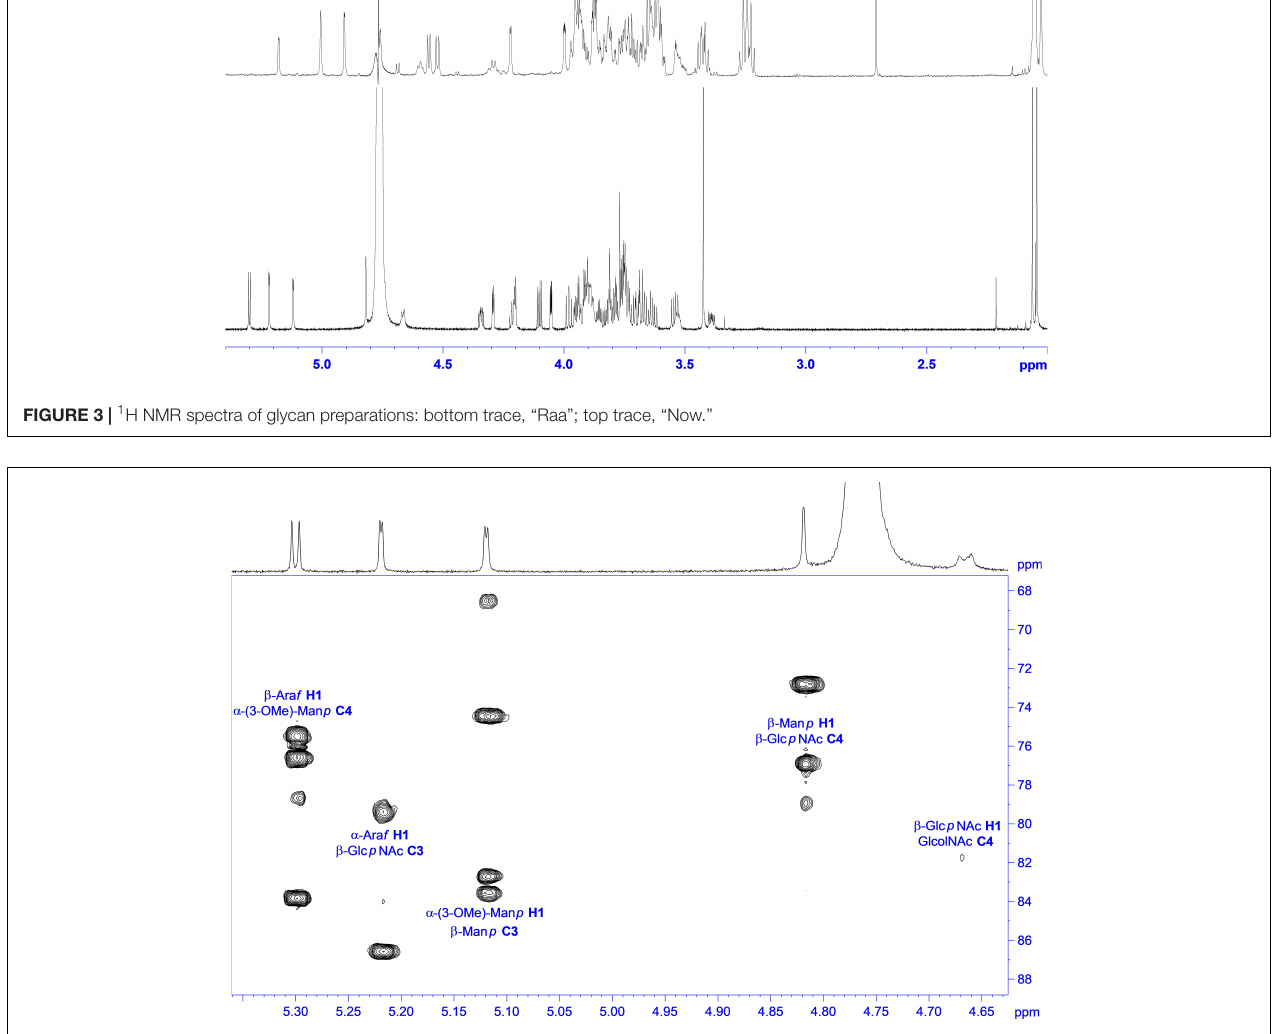
FIGURE 4 | 1 H, 13 C HMBC spectrum of “Raa” with annotation for the linkage